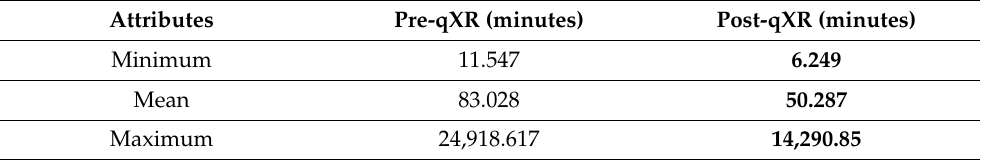
Table 4. Summary statistics of TAT analysis between pre-qXR and